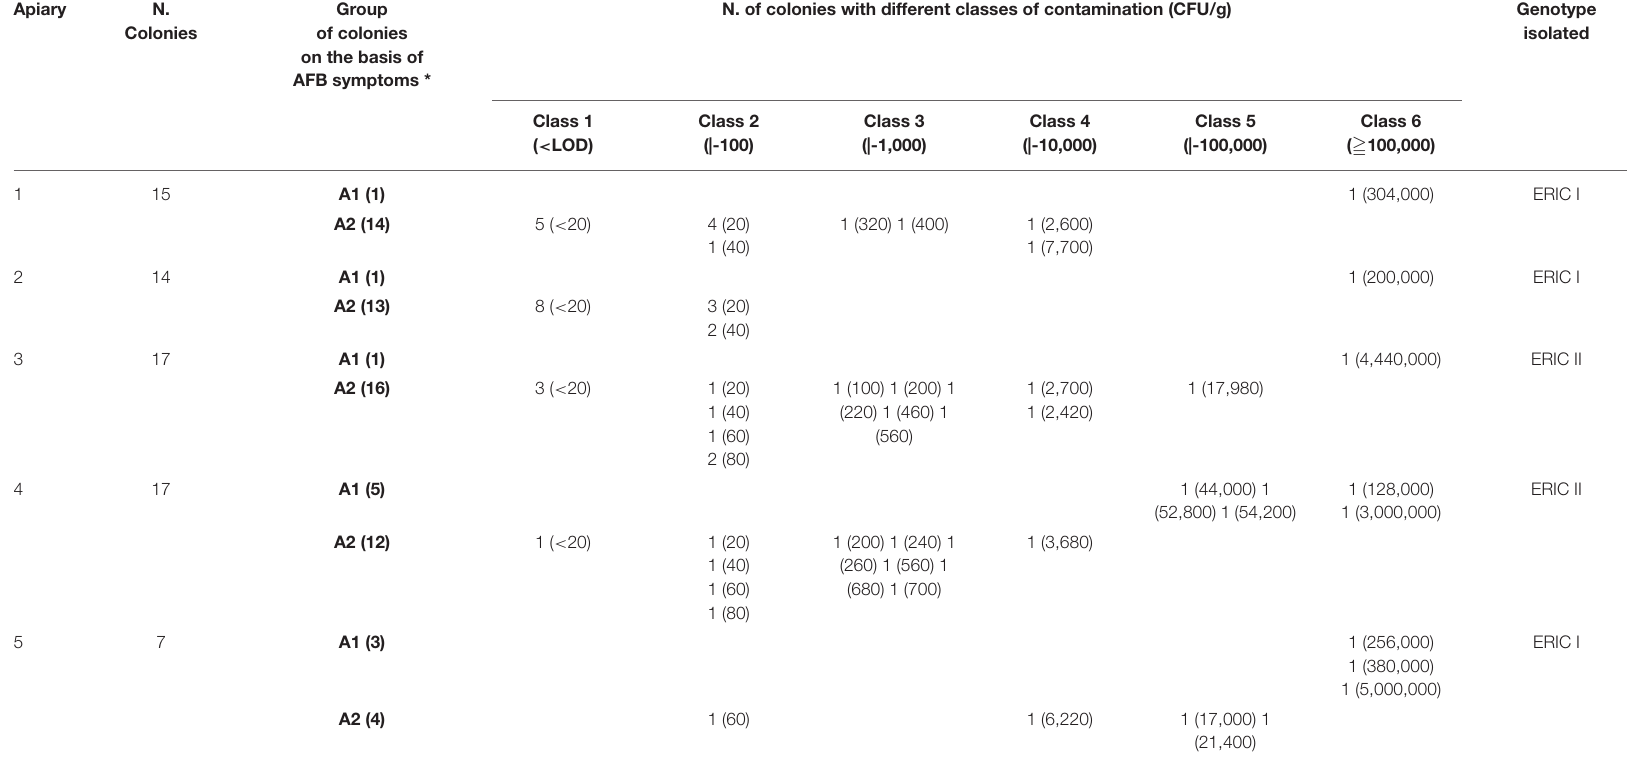
* Group A1 , Colonies with clinical symptoms of AFB. Group A2 , Colonies without clinical symptoms of